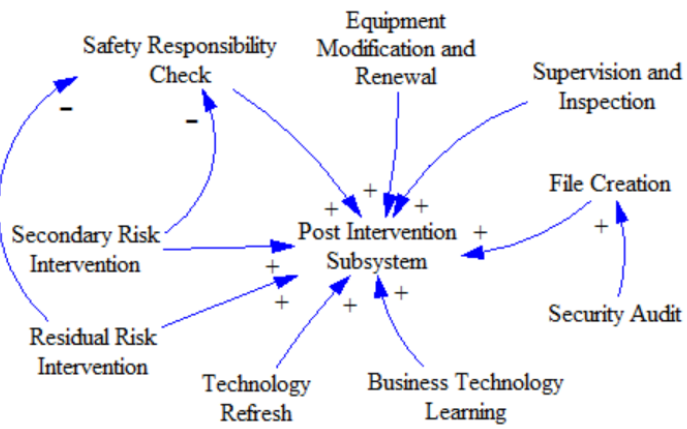
Figure 10. Intervention causal diagram of grid G H .